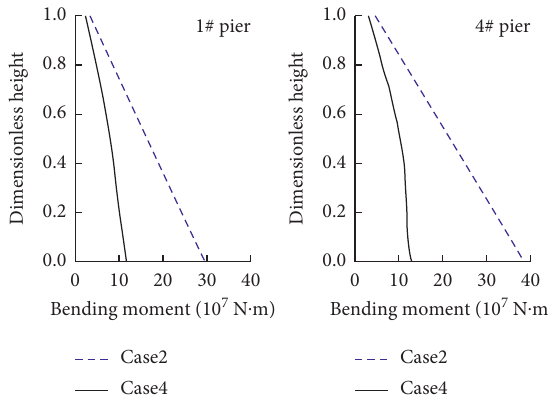
Figure 14: Bending moment envelopes of piers in Cases 2 and